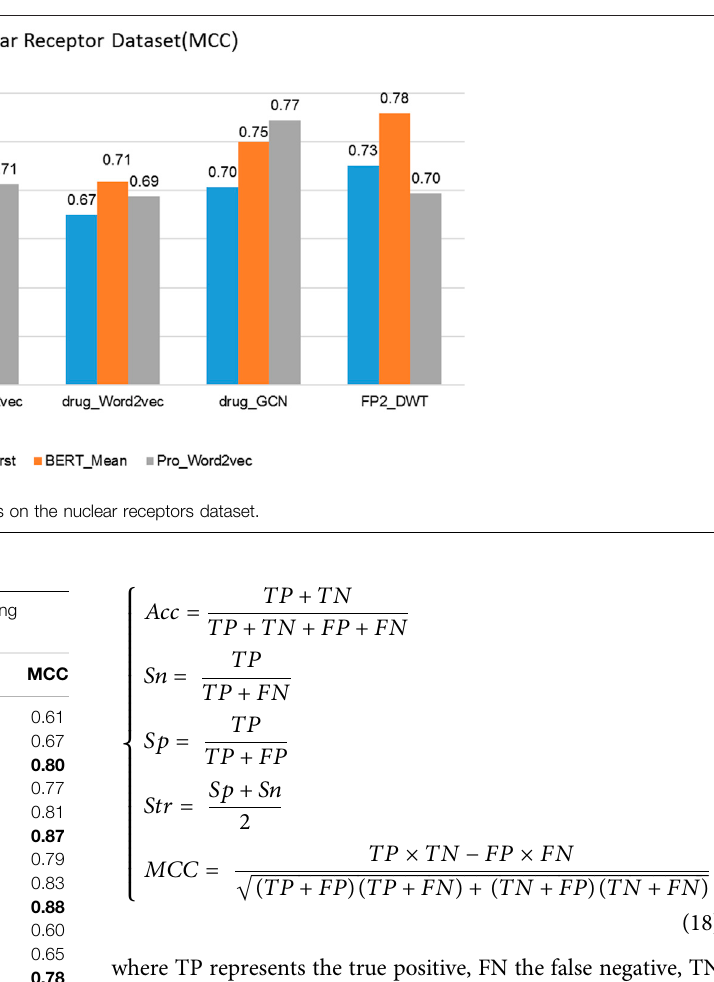
The best results for each metric are in bold.